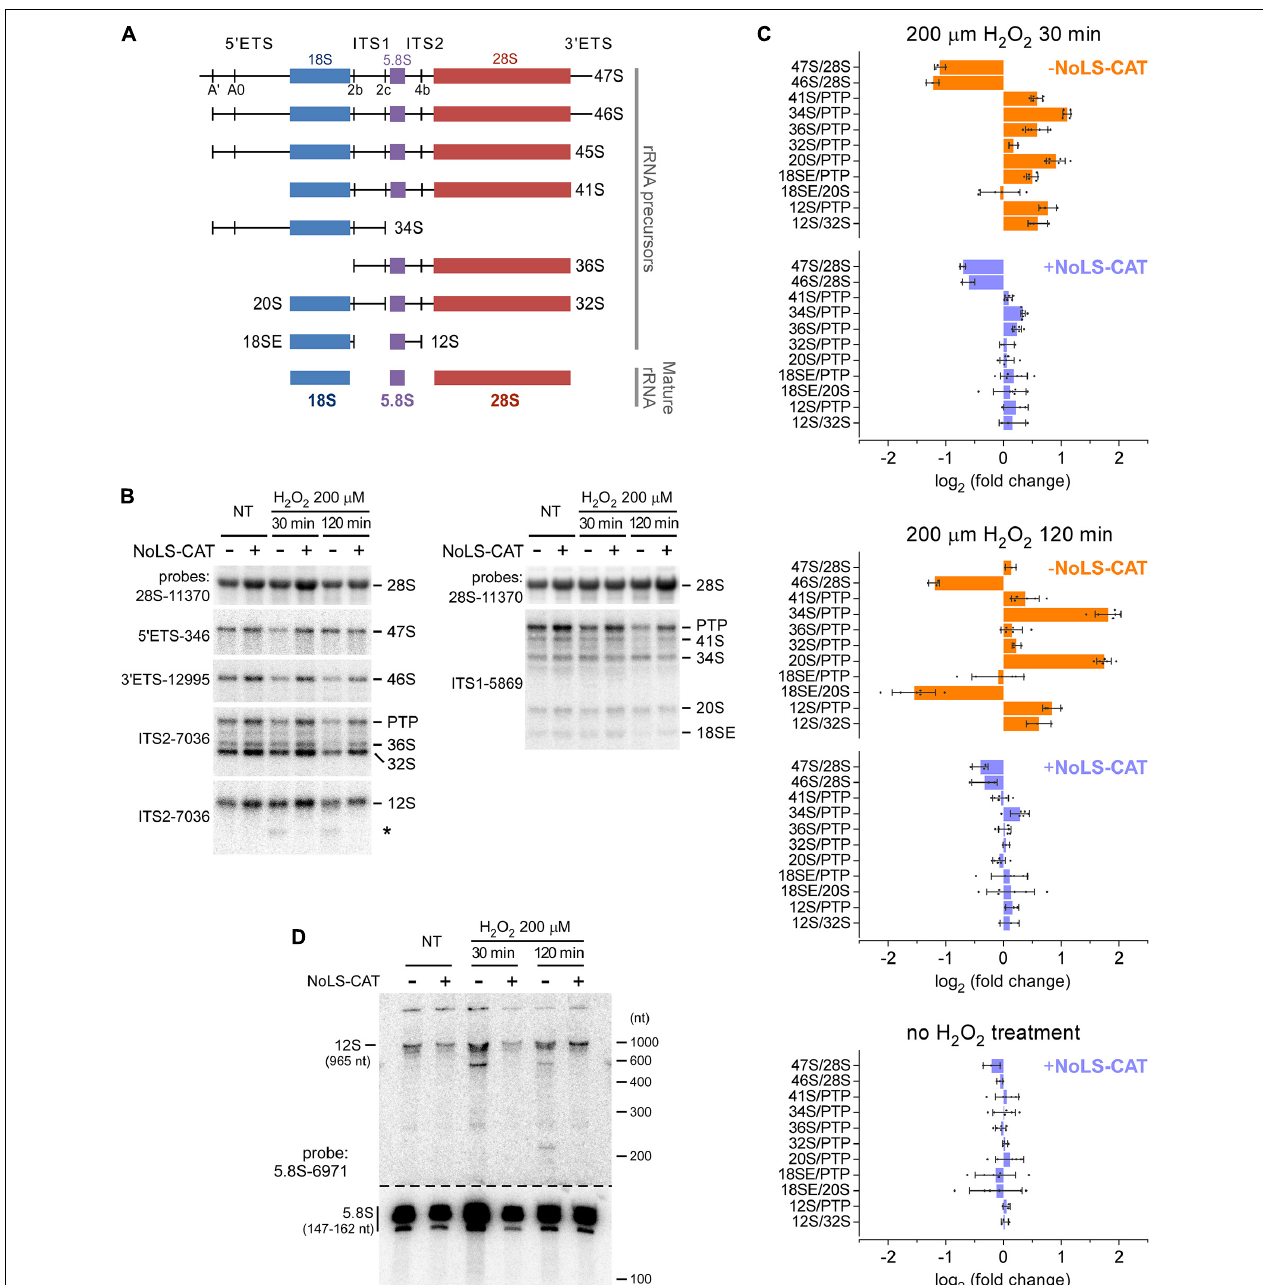
FIGURE 4 | Alterations in pre-rRNA processing after H 2 O 2 exposure. (A) The main pre-rRNA processing intermediates in mouse cells. Major cleavage sites in the primary 47S pre-rRNA are shown at the top. (B) Northern blot analysis of pre-rRNA processing. pNoROS-CAT-transfected pools were either not treated (NT) or treated with H 2 O 2 for the indicated times. For NoLS-CAT induction, Dox was added to medium 24 h prior to H 2 O 2 treatment. RNA was resolved on 1% agarose-formaldehyde gels, blotted onto nylon membranes, and hybridized with radiolabeled probes. Representative hybridizations are shown as examples. PTP refers to the band consisting of the p rimary t ranscript (47S) plus its derivatives 46S and 45S, all three of which comigrate on agarose gels. Asterisk marks an aberrant product of incomplete 3 (cid:48) processing of 12S pre-rRNA appearing after H 2 O 2 treatment. (C) RAMP plots showing changes in precursor ratios relative to those in control cells that were neither exposed to H 2 O 2 nor expressed NoLS-CAT. Individual data points correspond to values obtained from three biological replicates; some hybridizations were further performed in two technical repeats. Bars show mean values, error bars show sd. (D) Northern blot analysis of the 12S to 5.8S processing. RNA was resolved on an 8% polyacrylamide-urea gel, transferred onto a membrane, and hybridized with a 5.8S rRNA probe. To avoid signal saturation by the abundant 5.8S rRNA, the bottom part of the membrane was cut out and exposed separately for a ∼ 10-fold shorter time than the top part containing 5.8S